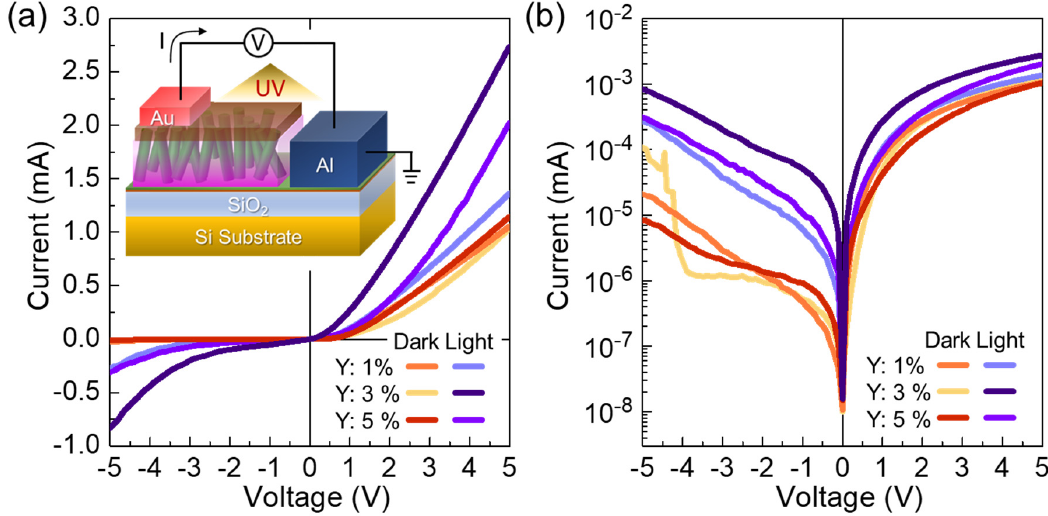
Figure 3. I–V characteristic curves of the PFO / YZO-NR PDs (Y: 15%) under dark and UV illumination (P opt = 0.2 mW / cm 2 ): ( a ) linear scale and ( b ) semi-logarithmic scale.